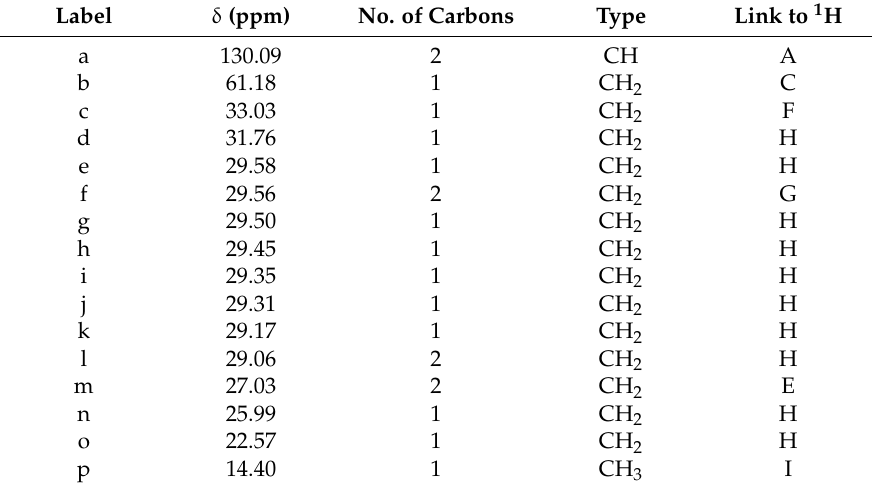
Table 2. Summary of 13 C-NMR data for the lipid molecule as revealed by 1D 13 C-{ 1 H} and 2D [ 1 H, 13 C] HSQC-NMR